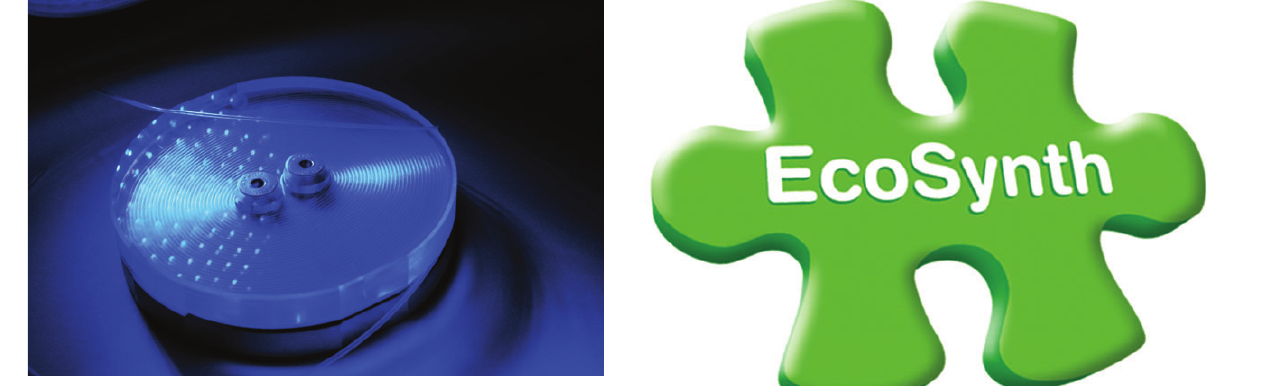
Figure 1 Modular photo+flow system designed by EcoSynth.